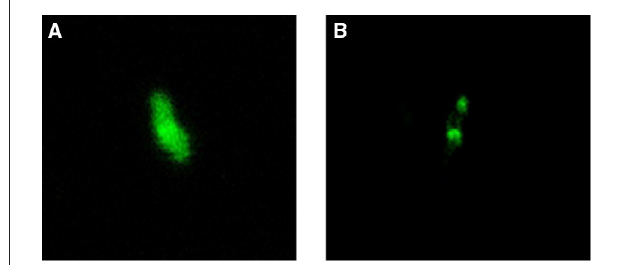
FIGURE 3 | Subcellular localization of the Cj0371 protein. (A) C. jejuni 1 cj0371 expressing GFP. (B) C. jejuni 1 cj0371 expressing Cj0371-GFP proteins.